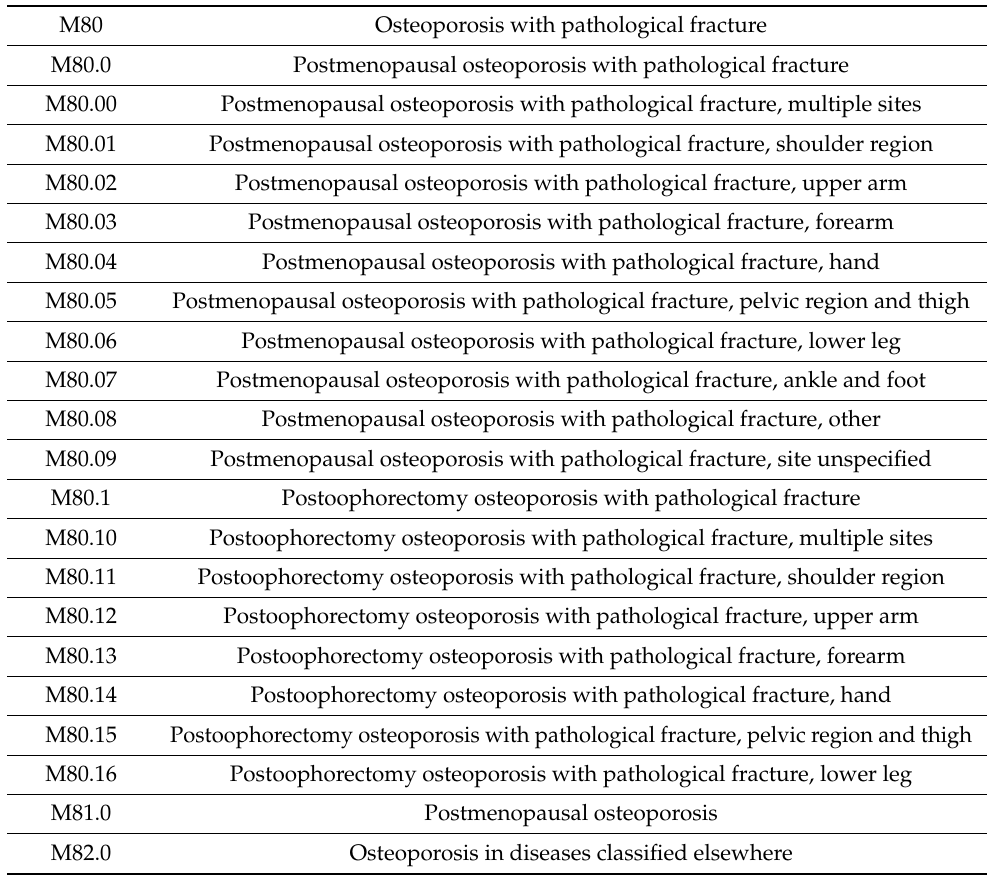
Table 2. Diagnostic codes for patients with osteoporosis, as defined by the Korean Informative Classification of